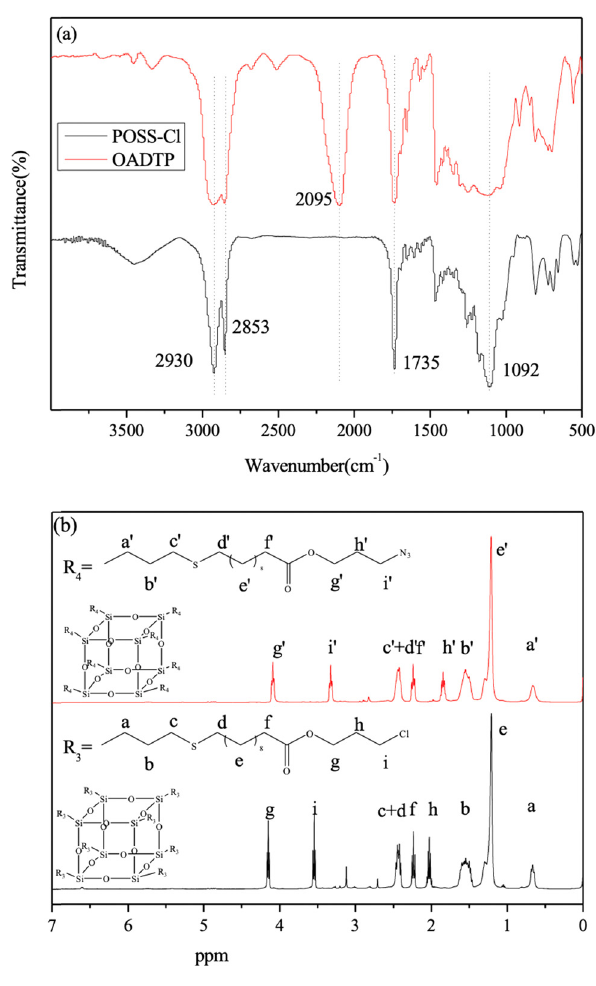
Figure 3: The FT - IR ( a ) and 1 H - NMR ( b ) spectra of POSS - Cl and OADTP.